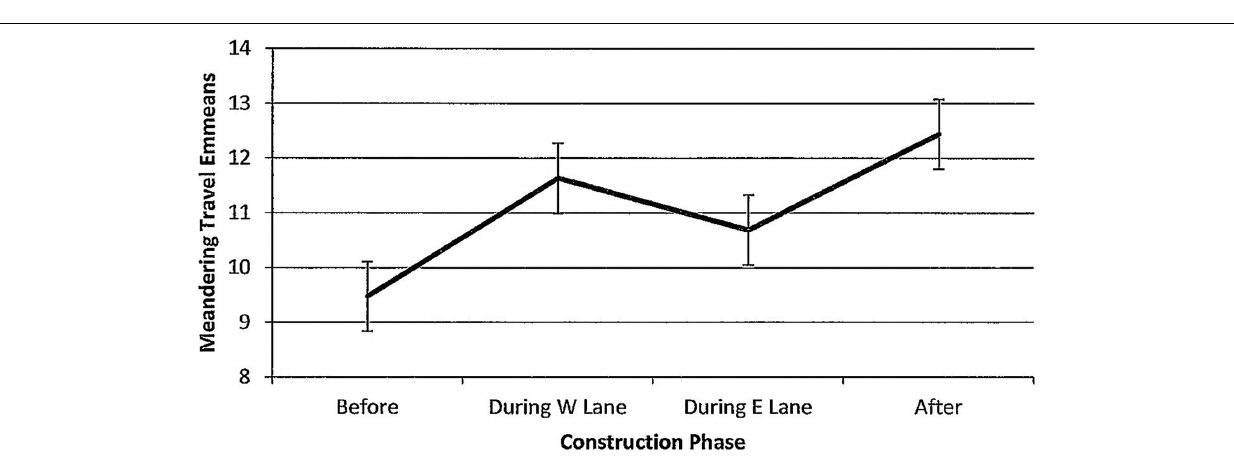
FIGURE 14 | Estimated marginal means of numbers of dolphins engaged in meandering travel around the construction zone before, during, and after